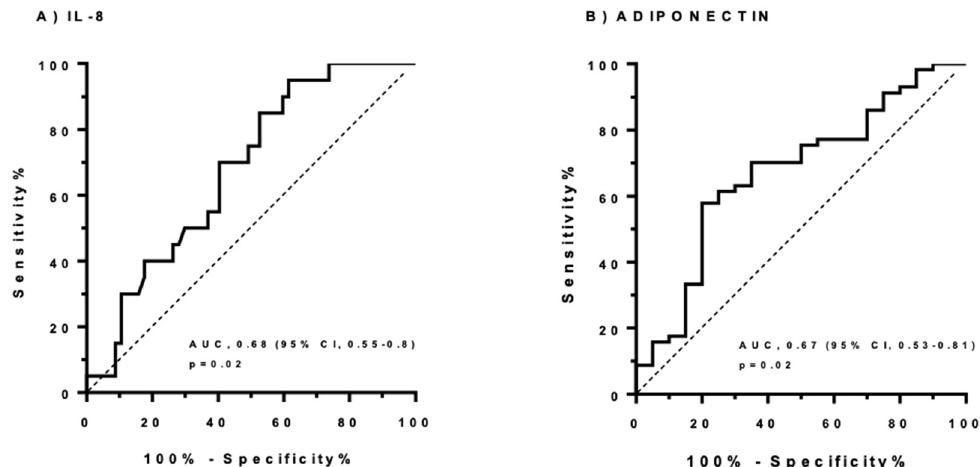
Figure 4. Receiver operating characteristic (ROC) curves for NASH diagnosis. ( A ) ROC curve for the association between plasma IL-8 levels (pg / mL) and NASH diagnosis in MO patients. ( B ) ROC curve for the association between plasma adiponectin levels (ng / mL) and no NASH diagnosis in MO patients. The dashed line is a reference line indicating chance prediction. AUC denotes area under the